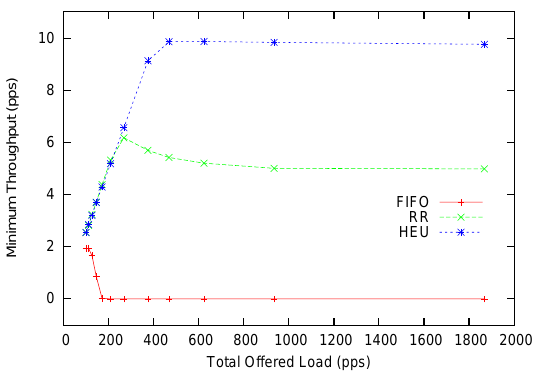
Figure 8. Minimum throughput performance with Poisson